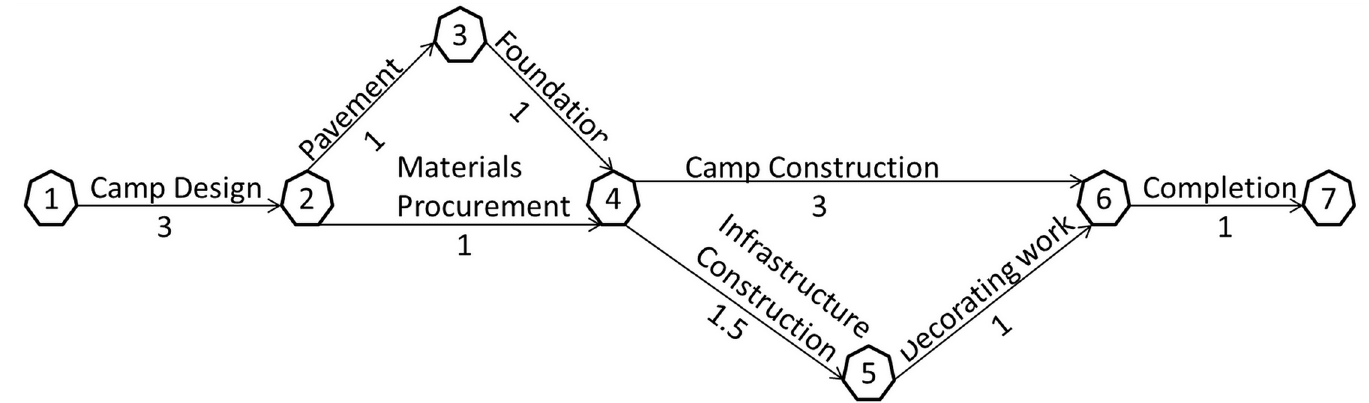
Fig 2. PERT/CPM used in an example of mine camp construction (with working time in week).